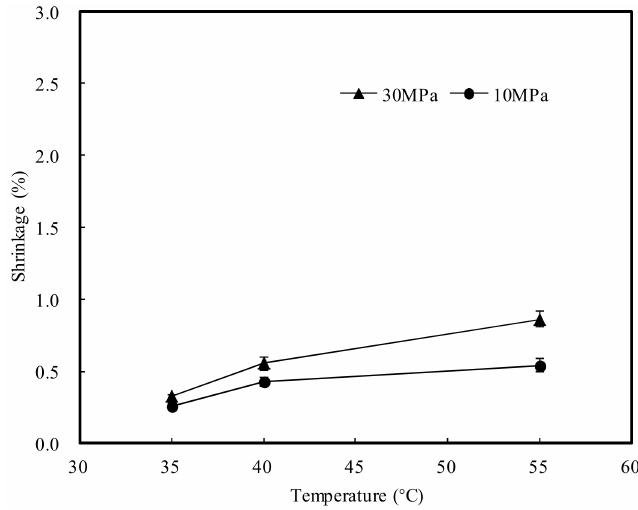
Figure 7. Effects of pressure and temperature on